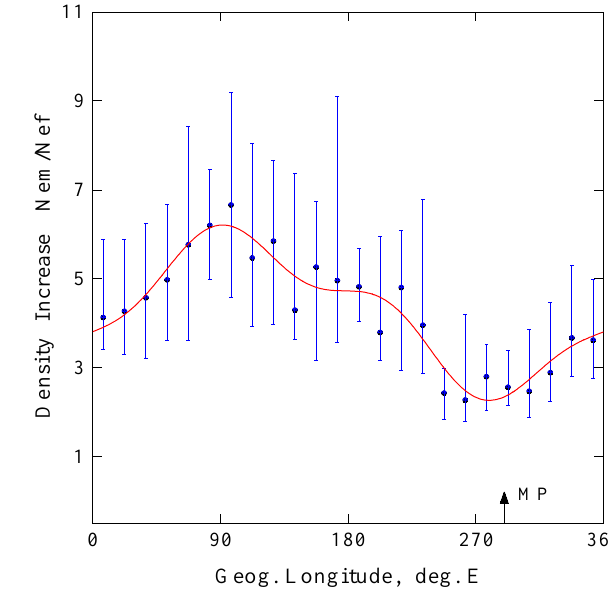
Fig. 5. Location of the polar cliff as function of magnetic local time. The format of data presentation corresponds to that in Fig. 4, except that this time linear regression lines have been fitted to the median values. Again, the results refer to a geomagnetic activity level of AE6=250nT.